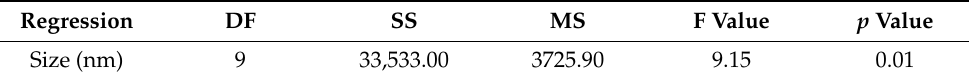
Table 7. ANOVA, degree of freedom (DF), sum of squares (SS), mean of squares (MS), and Fischer’s ratio (F-value) for the size of the NPs.